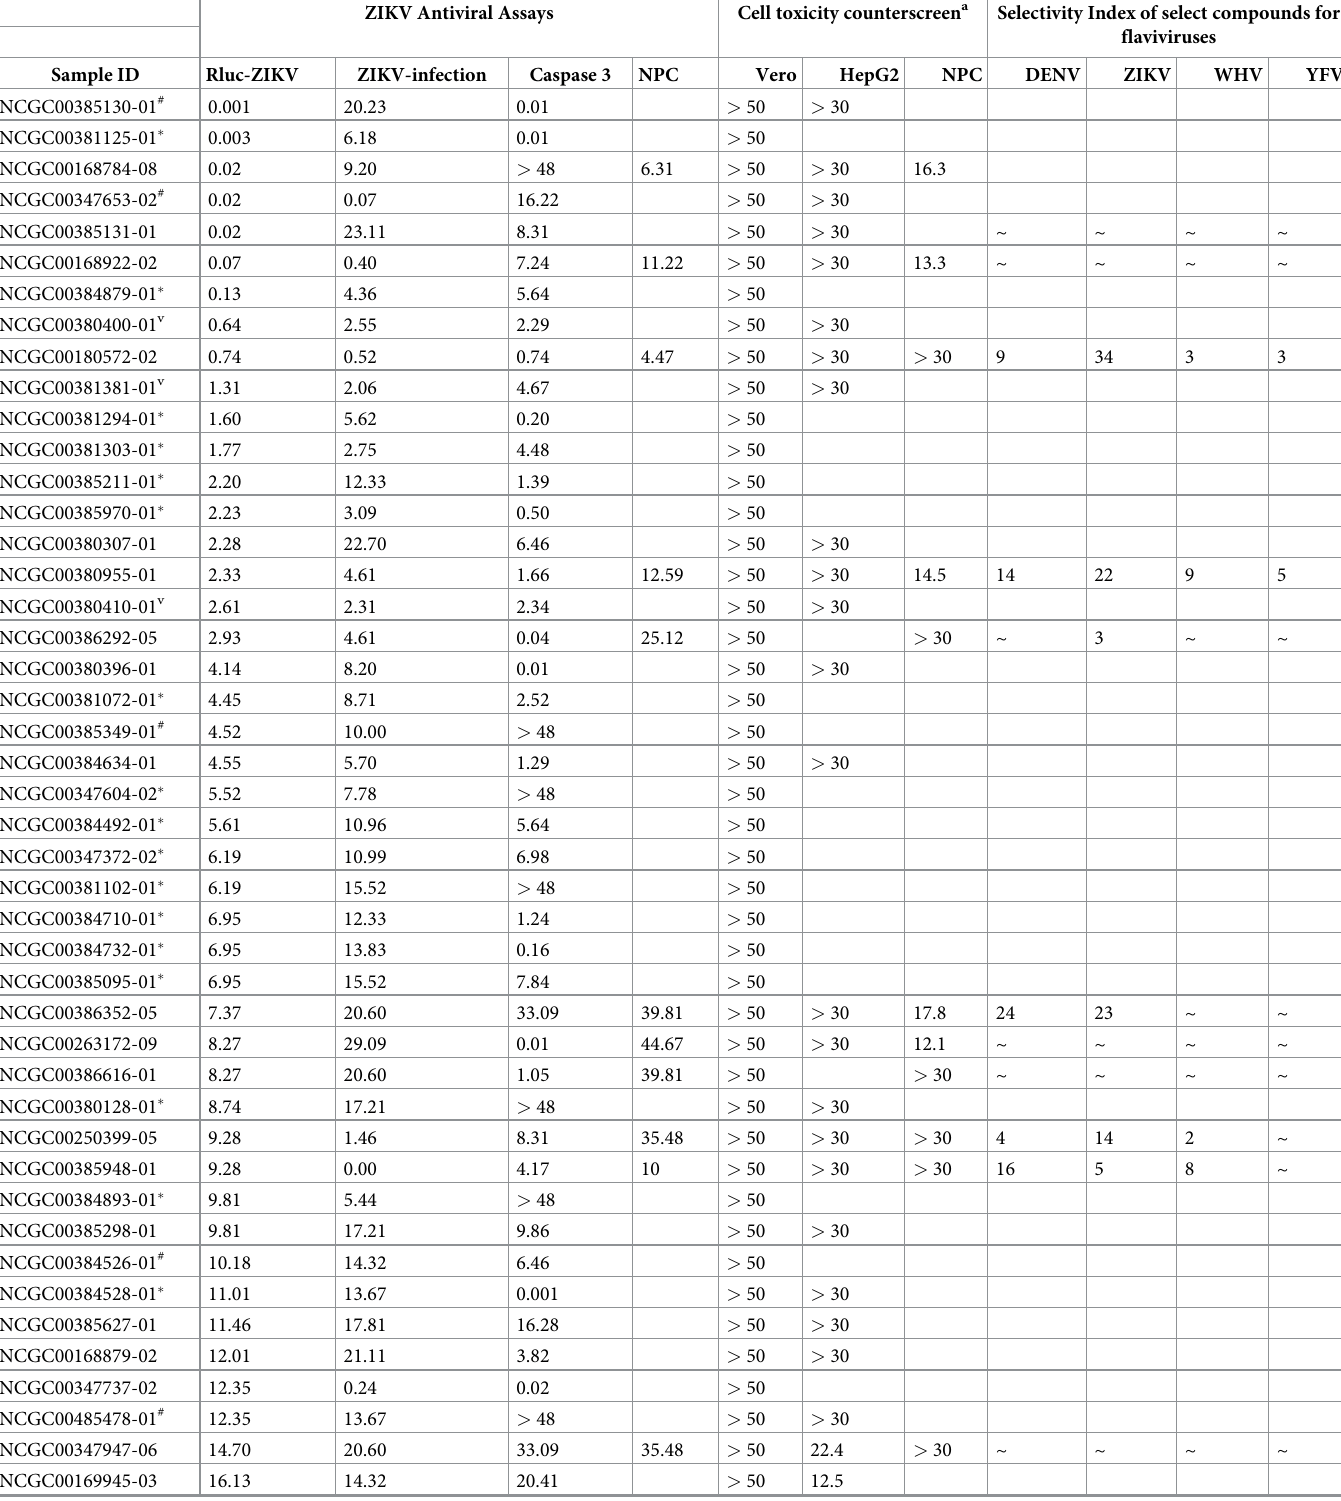
Table 1. Select compound response in antiviral and counter screen assays. ZIKV Antiviral Assays Cell toxicity counterscreen a Selectivity Index of select compounds for